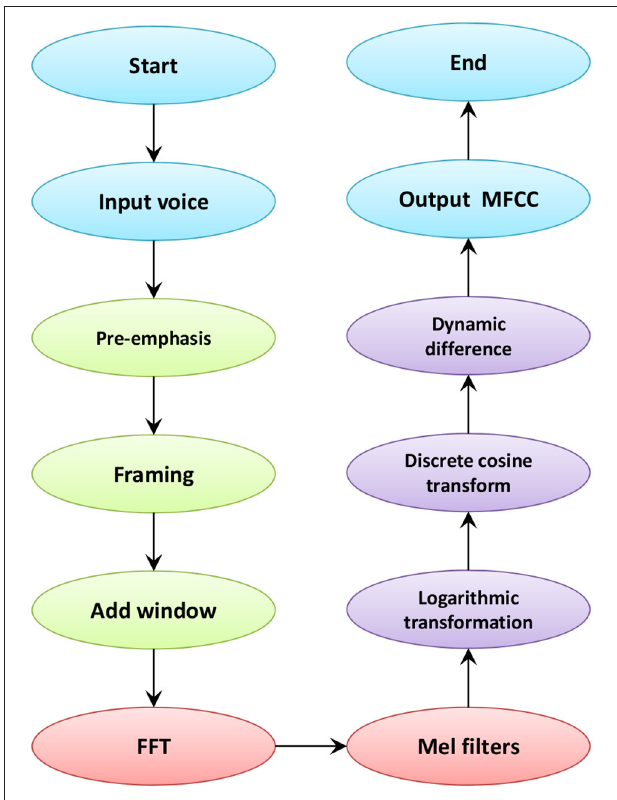
FIGURE 4 | The process of MFCC